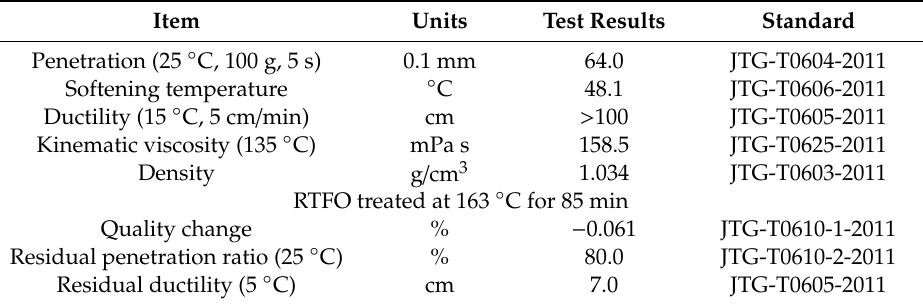
Table 1. Properties of base asphalt binder.